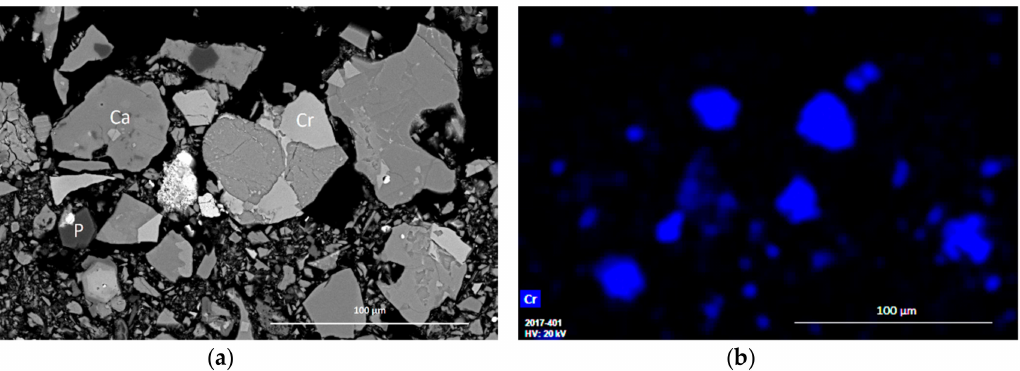
Figure 6. ( a ) SEM-BSE image of the SS slag showing Ca, CaMg, and CaMgAl silicates (grey, Ca), periclase (dark grey, P), and Cr-rich spinel (magnesiochromite, light grey, Cr). The bright white particle is stainless steel. ( b ) EDX Cr distribution map showing that Cr is present in magnesiochromite, and in lower concentrations in the metal.